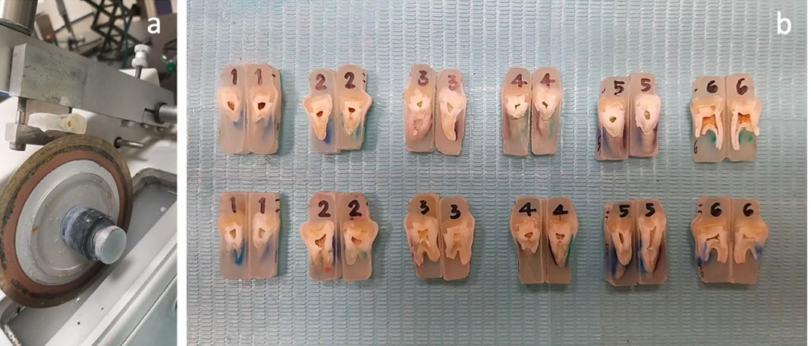
Figure 5. ( a ) Specimens were sectioned and prepared for scanning electron microscopy (SEM). ( b ) Labelling the samples according to the designated group (digit placed above).